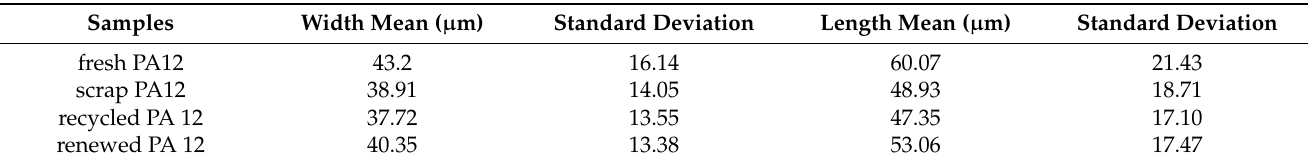
Table 2. Particle size values obtained from image analysis obtained from statistical analysis regarding the width and length of particles.